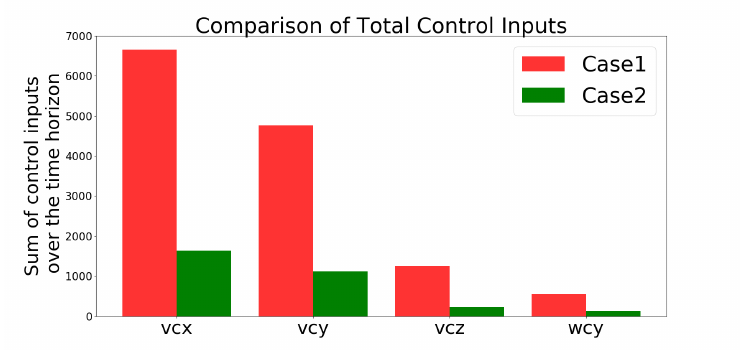
Figure 24. Comparison of the total amounts of the control